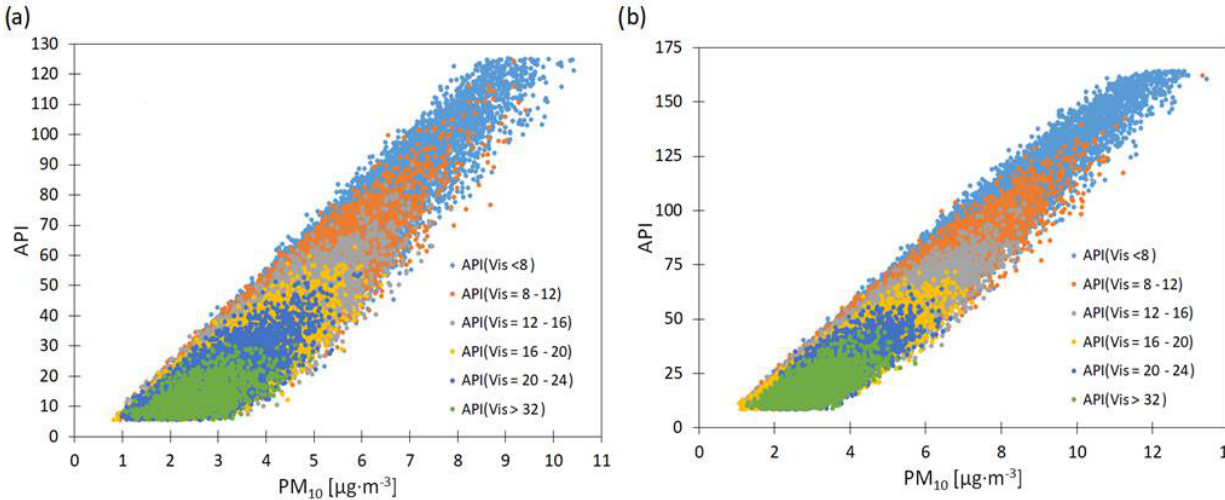
Figure 7. Influence PM 10 air concentration depending on the air quality index for ( a ) wet and ( b ) dry periods in winter season.